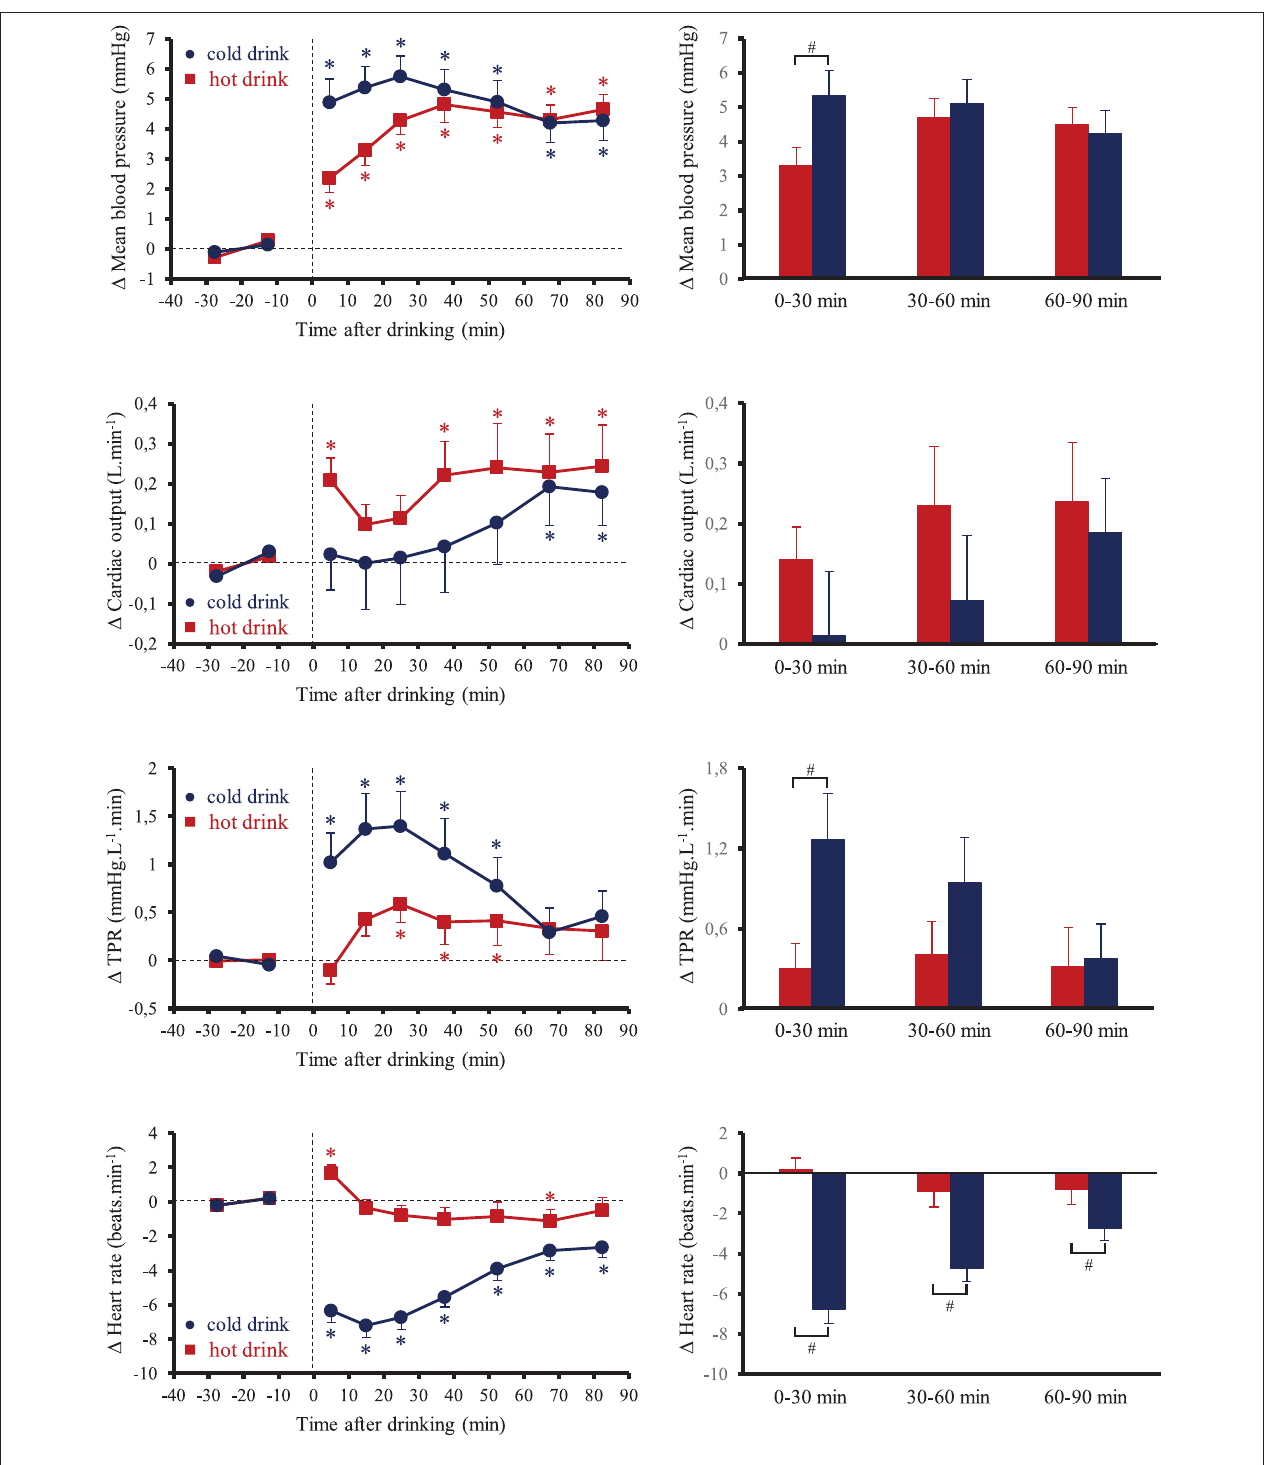
FIGURE 1 | (Left) Time course of the changes in mean blood pressure, cardiac output, total peripheral resistance (TPR) and heart rate. (Right) Mean responses averaged over 0–30, 30–60, and 60–90min relative to baseline values and presented as a delta (i.e., average over 0–30, 30–60, and 60–90min post-drink period, respectively, minus the average over the 30-min baseline period). Drinks: hot tea ( (cid:4) and ); cold tea ( (cid:8) and ). * p < 0.05 significant differences over time from baseline values; # p < 0.05 significant differences between responses to the drinks.